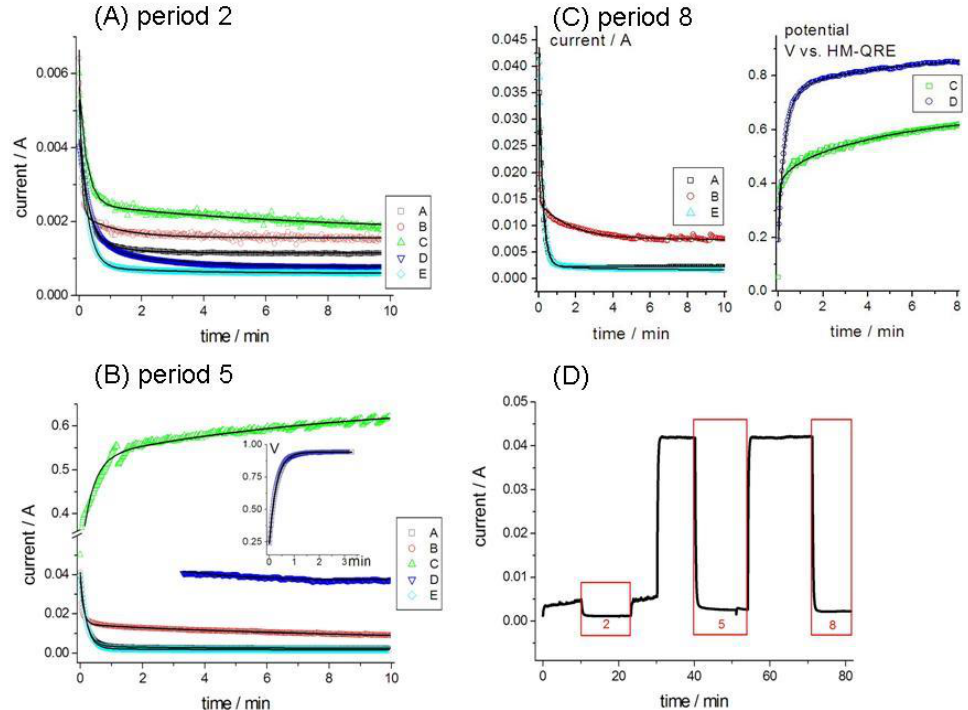
grades was carried out using the following potentials: A, 0.70V HM-QRE ; B, 0.80V HM-QRE ; C, 1.0V HM-QRE ; D, 0.90V HM-QRE ; and E, 0.75V HM-QRE . ( a , b ) Onset of abrasion in tap water; ( c ) NaCl injection during abrasion; ( d ) onset of abrasion in the presence on NaCl; ( e ) hexane injection. Scatter plots correspond to experimental data, continuous lines are best fits. Panel ( f ) shows the collocation of the transients displayed in Panels ( a – e ).